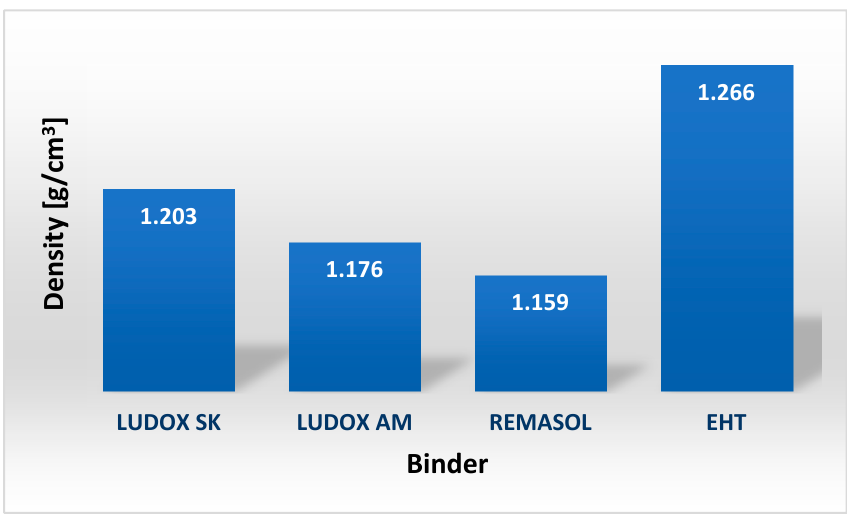
Figure 18. The density of binders produced based on colloidal silica.